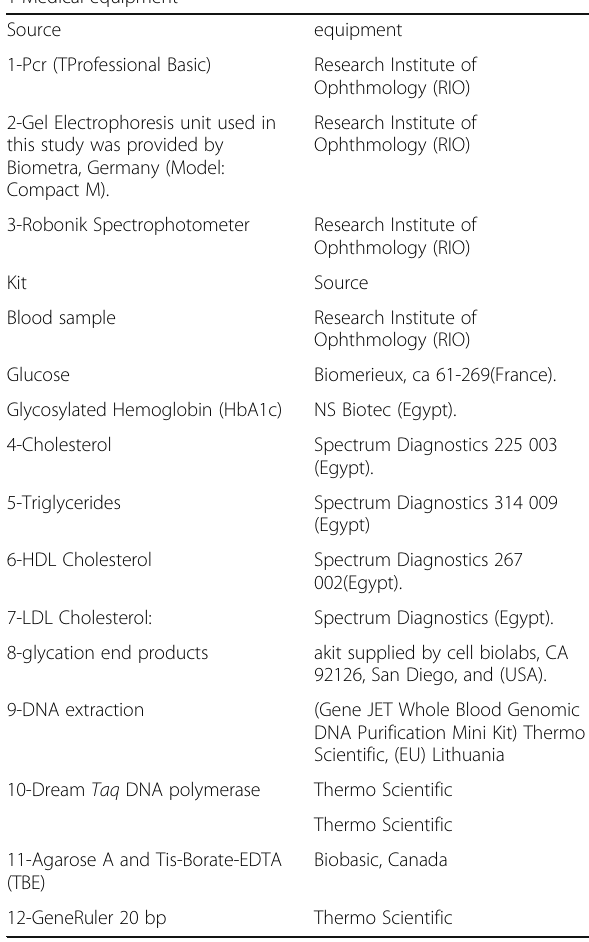
complication among Japanese patients (Amano et al.